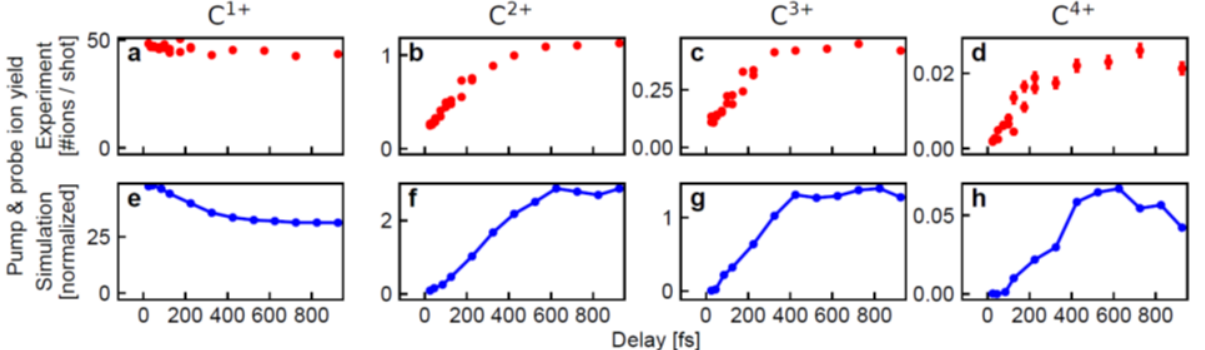
Figure 3. Comparison between experiment and modeling of the time-resolved ionization and fragmentation dynamics of C 60 displaying charged atomic C fragments. The top panels show the measurements while the bottom panels show the calculations. Panels ( a , e ) show the C 1+ ; ( b , f ) show the C 2+ ; ( c , g ) show the C 3+ ; and ( d , h ) show the C 4+ fragment ions. See text for details.